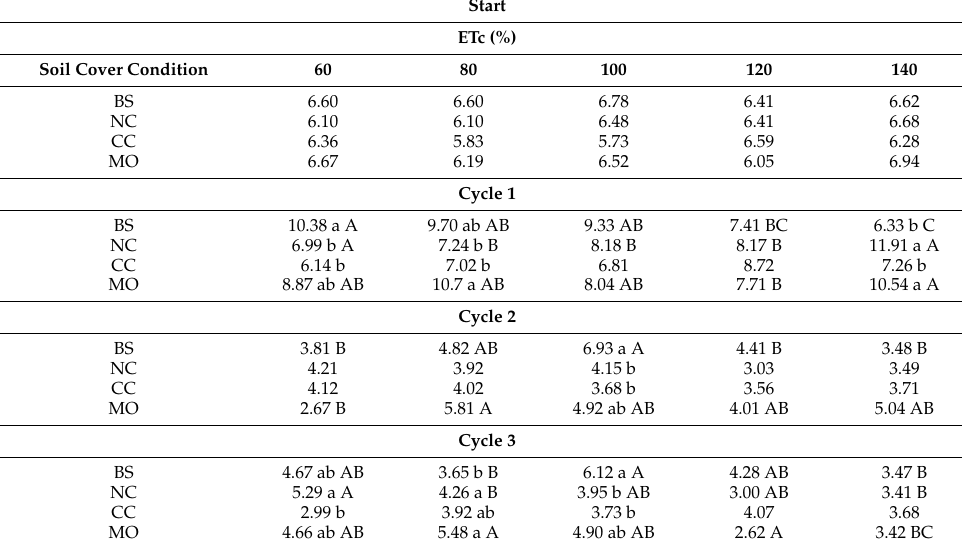
Mean values in the same columns followed by the same lowercase letters and on the lines, capital letters did not differ according to Tukey’s test ( p < 0.05) in relation to the soil cover conditions and in the lines in relation to the applied irrigation depths.